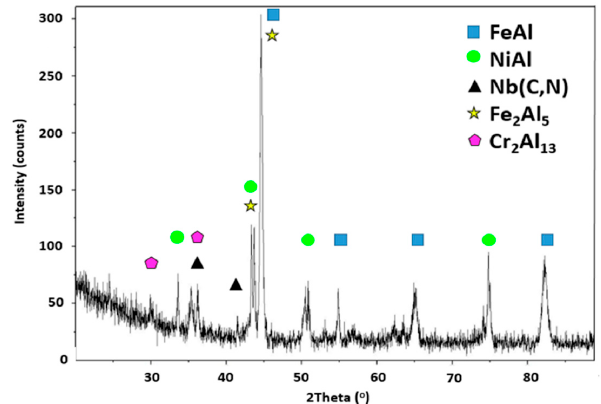
Figure 2. XRD pattern of a slurry aluminide coating deposited on HT347HFG steel after being heat treated for 1 h at 700 °C and 2 h at 900 °C.